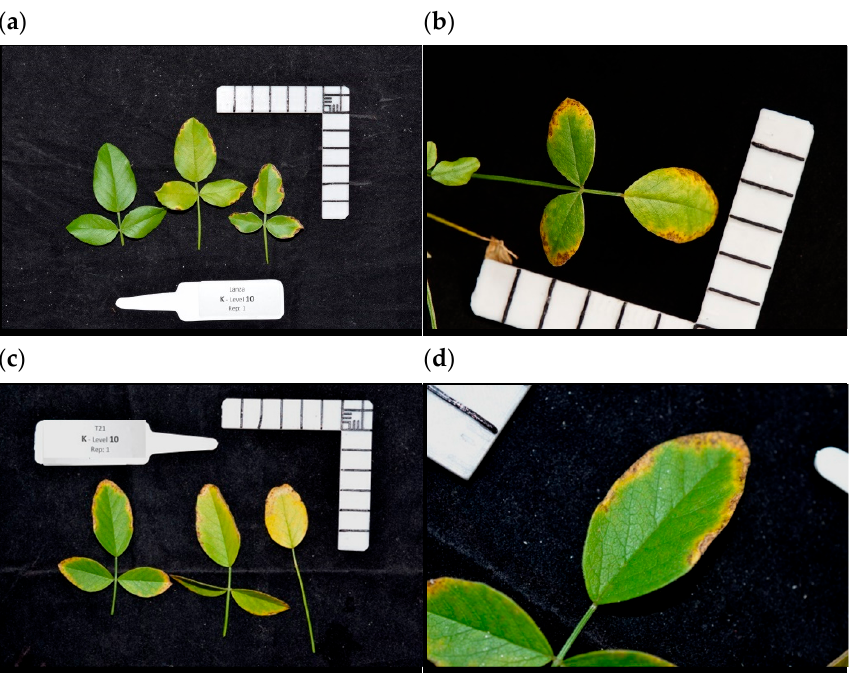
Figure 9. Leaf symptoms of potassium toxicity in Lanza ® tedera ( a , b ) and Palma ( c , d ). Tedera genotypes demonstrated little shoot biomass response to soil S compared to lucerne (Figure 2c). Indeed, increasing soil S had no significant effect on Palma. Increasing soil S did lead to a significant increase in shoot S concentrations for all genotypes up to the maximum soil S tested. Assuming the highest soil S produced peak productivity, 90% of peak productivity for Lanza ® occurred above 7.4 mg kg − 1 Soil S, and lucerne achieved 90% peak productivity between 3.8 and 20.2 mg kg − 1 soil S (NB. this higher value was extrapolated beyond the values tested here). Within the soil S values tested here, 90% of peak productivity coincided with shoot S concentrations of 0.22% and 0.12% for Lanza ® and lucerne, respectively. The peak productivity of Lanza ® among the soil S values tested was 5.8 g pot − 1 and occurred at 13 mg kg − 1 soil S (the highest tested). This was a 57% in- crease over the productivity of Lanza ® at the lowest soil S concentration. In contrast, the peak productivity of lucerne was 12 g pot − 1 at 8.8 mg kg − 1 soil S and represented a 112% increase over the productivity at the lowest soil S. Sulphur deficiency was expressed in all genotypes as uniform chlorosis across the entire leaf lamina (Figure 10a,b), with mild black spotting and necrotic lesions in the worst cases (Figure 10b). Sulphur deficiency symptoms can be confused with N deficiency; how- ever, in this experiment, S deficiency led to more uniform chlorosis across the leaf (not inter-veinal) and across the plant as growing tips were affected (Figure 10c,d).